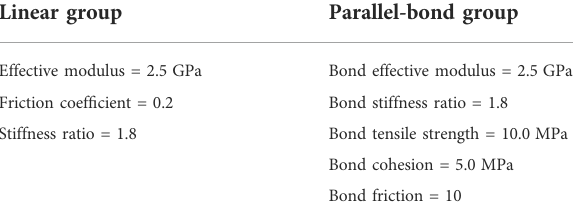
TABLE 3 Microscopic parameters of limestone (Liangfu et al.,